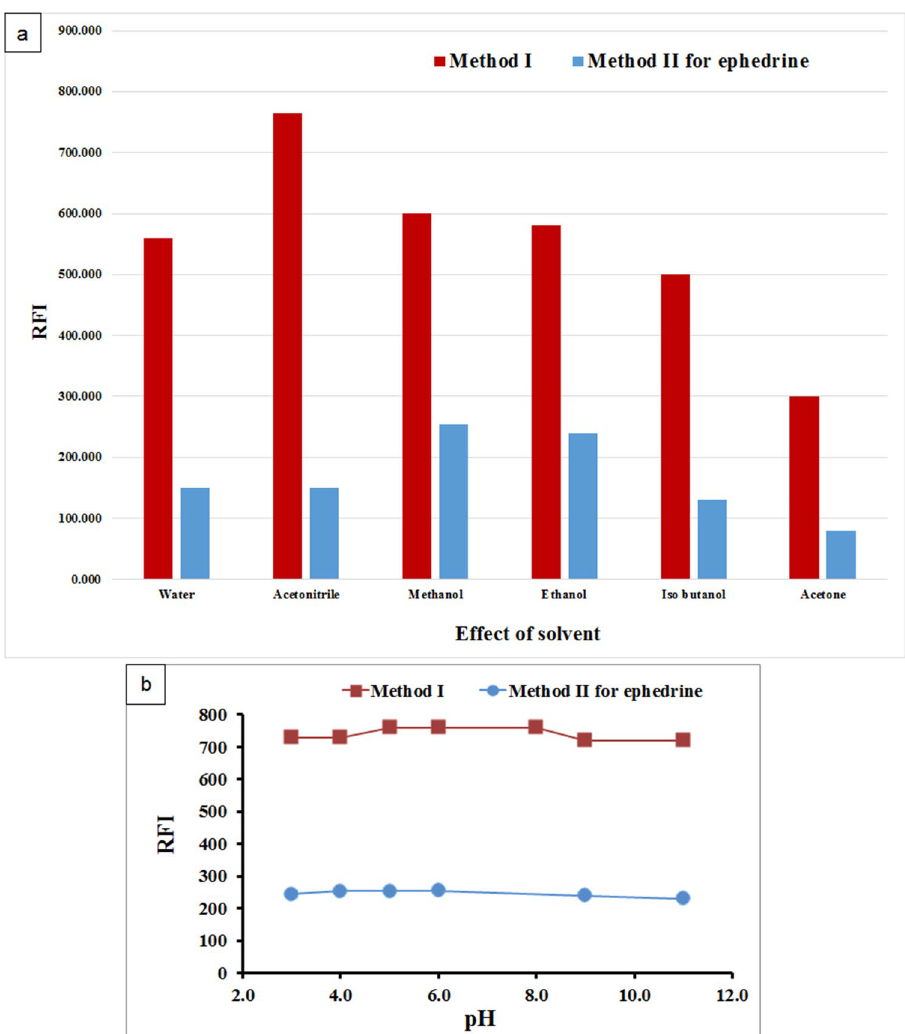
Figure 6. Effect of diluting solvent ( a ), pH ( b ) on synchronous fluorescence intensity of PHL (2.0 μg/mL) in method I and EPH (0.2 μg/mL) in method